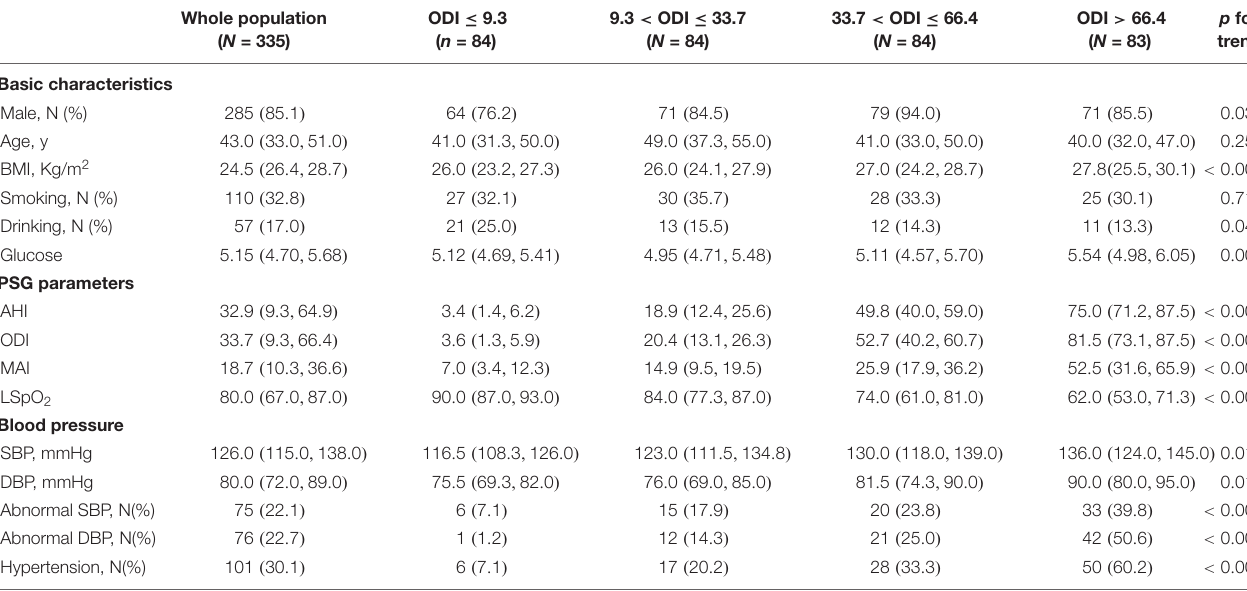
TABLE 1 | Characteristics and blood pressure of included subjects according to ODI